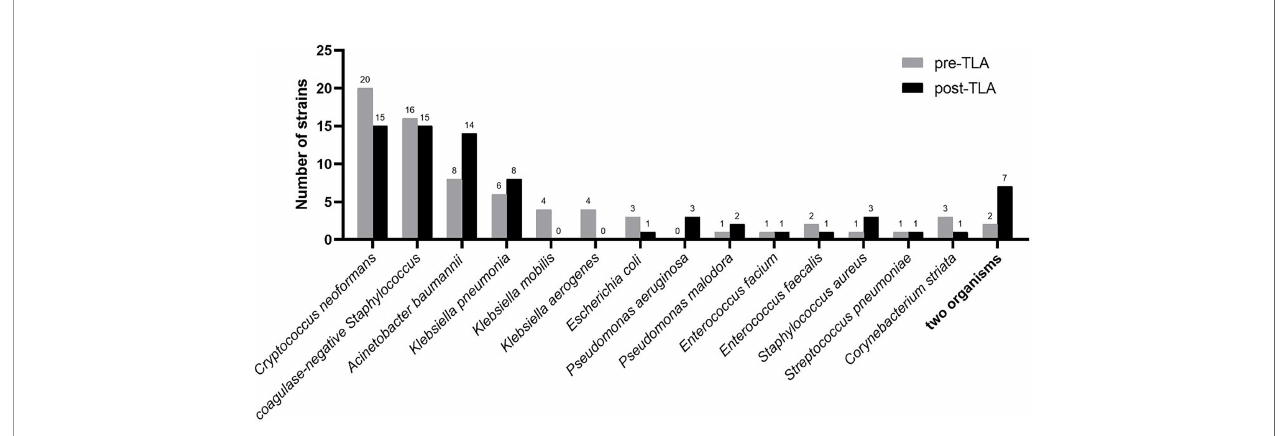
FIGURE 6 | Distribution of strains isolated from CSF in pre-TLA and post-TLA. CSF, cerebrospinal fl uid; TLA, total laboratory